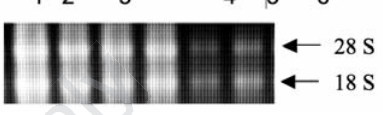
y y y y y y y l l l l l l l n n n n n n n o o o o o o Figure 2. Heat-denatured gel electrophore- Figure 2. Heat-denatured gel electrophore- Figure 2. Heat-denatured gel electrophore- sis of total RNA extracted from green- sis of total RNA extracted from green- sis of total RNA extracted from green- house-grown A. annua L. clones using two house-grown house-grown different methods. 1-3, TC1, TC2 and different methods. 1-3, TC1, TC2 and different methods. 1-3, TC1, TC2 Highland RNA using modified Highland RNA using modified cetyltrimethyl-ammonium bromide (CTAB); 4-6, TC1, TC2 and Highland RNA using CTAB and glacial acetic acid.